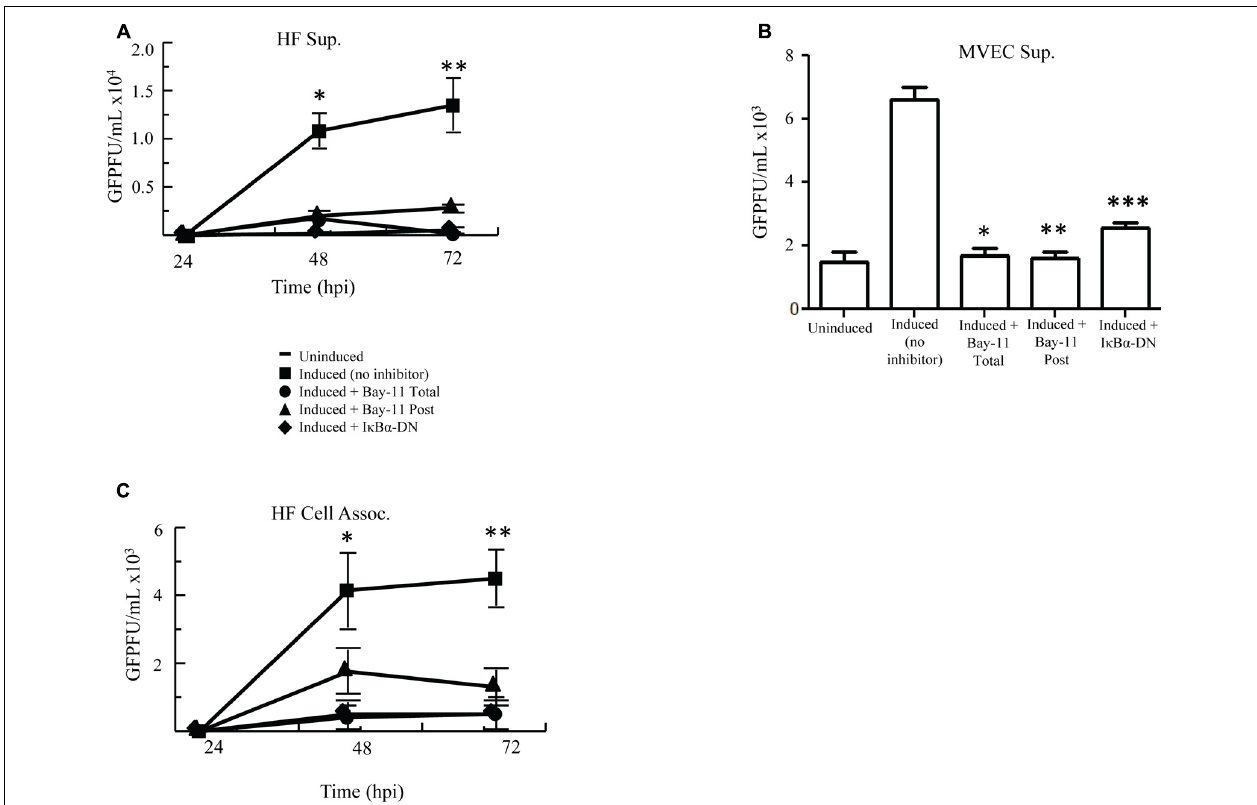
FIGURE 3 | Cell induction in the presence of NF κ B inhibition decreases viral titers. (A,B) rKSHV.219-infected HF (A) or MVEC (B) cells were either mock induced (Uninduced) or induced to undergo lytic replication with BacK50 (A) or Ad50 (B) and then treated with Bay11-7082 prior to induction (Total), at the time of induction (Post), or transfected with I κ B α -DN prior to induction. Supernatants were harvested at 24, 48, and 72 h post induction (A) and GFP forming units on 293 cells were measured. Using paired T test there was statistical significance between control induction and all treatment groups at both 48 h * p < 0.032,